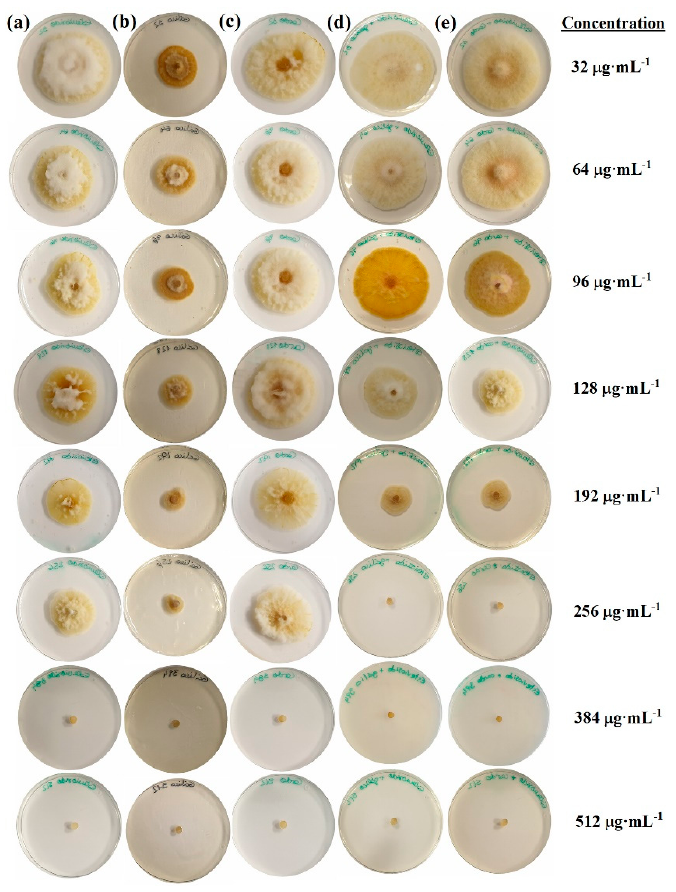
Figure 1. F. culmorum radial growth inhibition assays (“poisoned food method”) for the treatments based on ( a ) stevioside, ( b ) gallic acid, ( c ) milk thistle seed extracts, ( d ) stevioside–gallic acid, and ( e ) stevioside–milk thistle seed extracts. Only one replicate per treatment and concentration is shown. The control (PDA only) is not shown (radial growth = 60 mm).